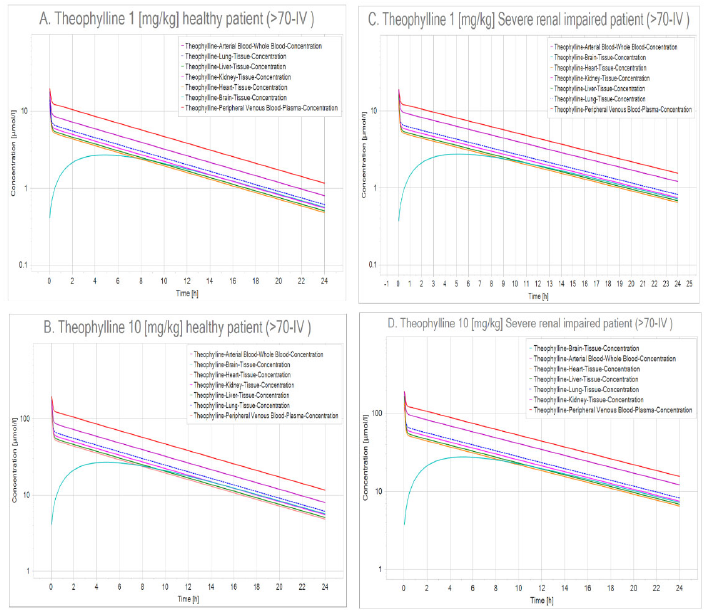
Figure 5. Physiologically based pharmacokinetic model (PBPK) simulation of theophylline at two concentrations modeled in a healthy patient and a patient with renal impairment. ( A ) Healthy patient dosed with 1 mg/kg, ( B ) Healthy patient that received 10 mg/kg, ( C ) Renal impaired patient administered 1 mg/kg. ( D ) Renal impaired patient dosed with 10 mg/kg. When results of the healthy patient were compared with those of the renal insufficiency patient, a slight increase in the time of theophylline body retention was observed in all organs studied (clearance reduction). Tissue concentration curves for the lungs (dotted blue curves) illustrate that the longest time for theophylline removal takes place in this tissue (Supplementary Materials Table